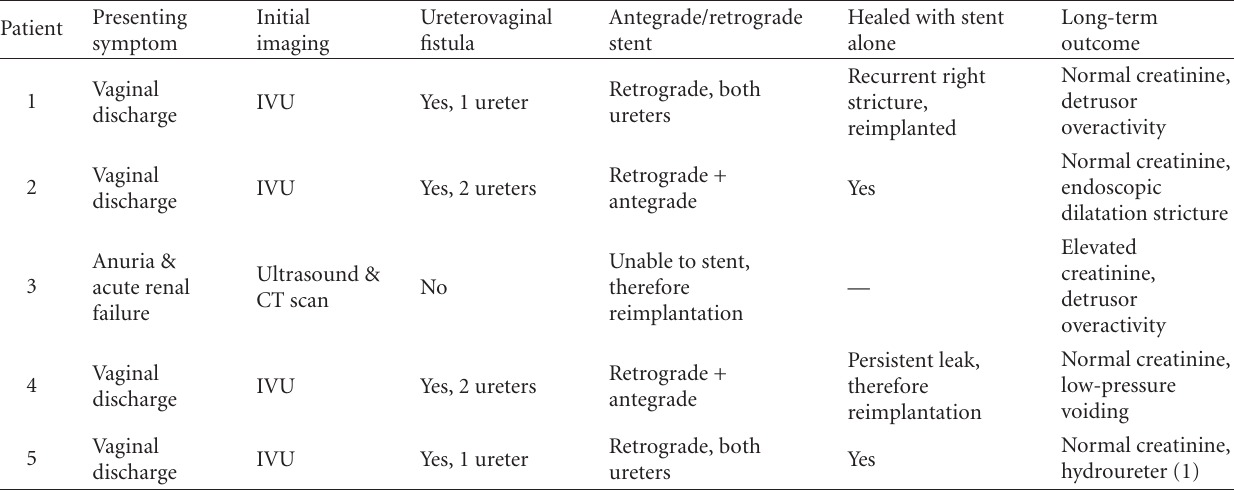
Table 1: Details of diagnosis, management, and outcome of patients with bilateral ureteric injury. Abbreviations: IVU (intravenous urogram), CT scan (computed